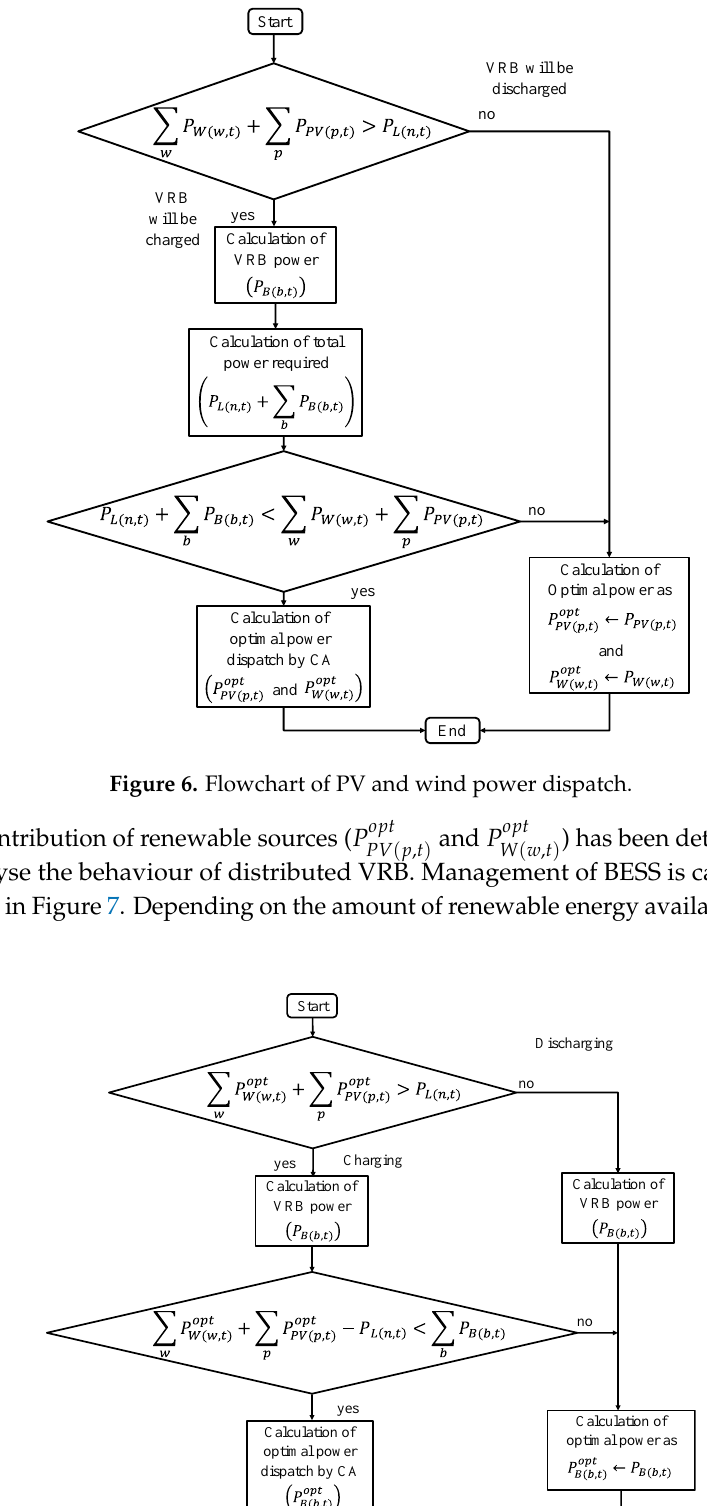
Figure 7. Flowchart of BESS power dispatch.